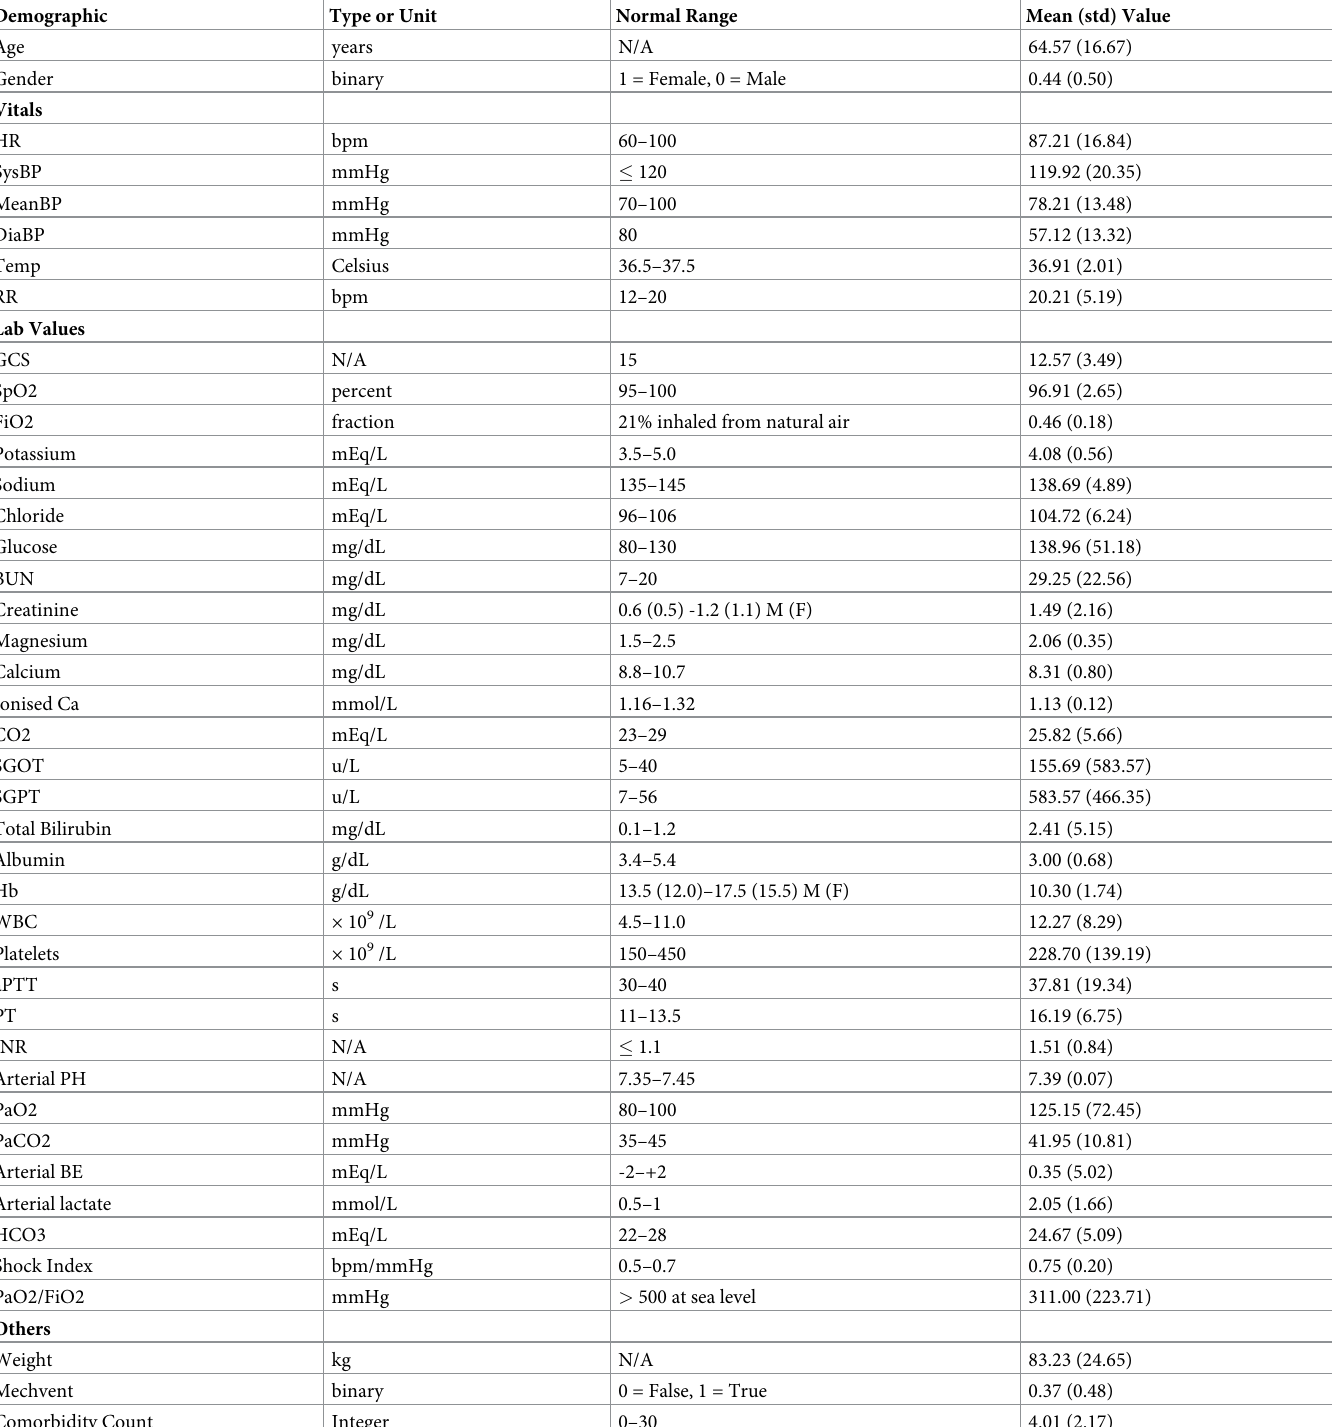
Table 1. Description of the